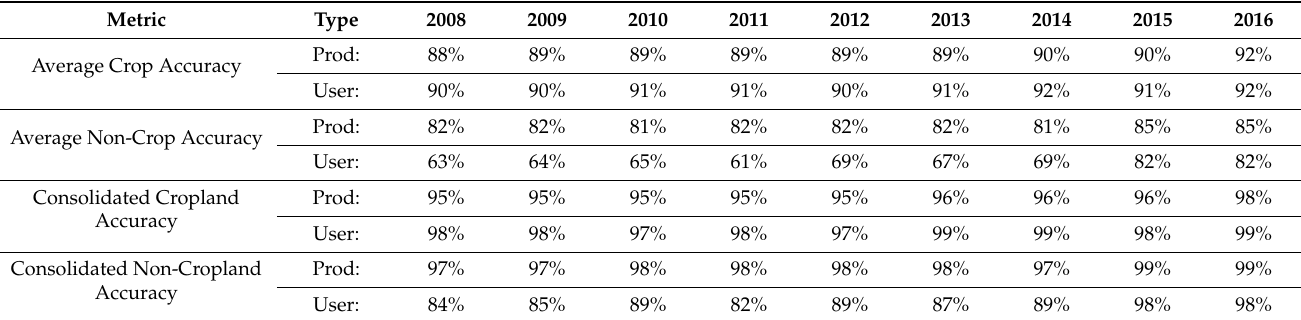
Table 3. Average specific class and consolidated class accuracies for each year of the CDL. Data from USDA NASS (2016) based on the comparison of CDL with data from Farm Service Agency (FSA) and National Land Cover Dataset (NLCD) and processed according to equations (7) and (8). Cropland and non-cropland domains based on class distinctions in Appendix A Table